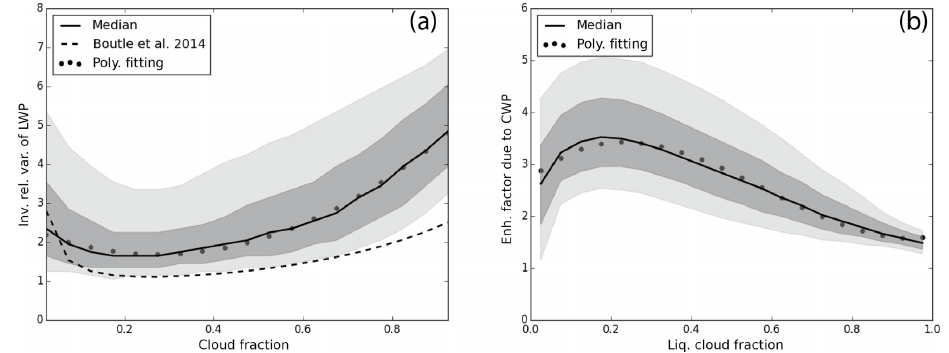
Figure 7. (a) The inverse relative variance v and (b) autoconversion enhancement factor due to LWP subgrid variability assuming lognormal PDF as a function of grid-mean liquid cloud fraction, where the solid line, dark shaded area, and light shaded area correspond to the median value, 25%–75% percentiles, and 10%–90% percentiles, respectively. The dotted lines correspond to simple third-order polynomial fitting. For reference, the v q (f liq ) parameterization scheme based on Boutle et al. (2014) is also plotted in panel (a)